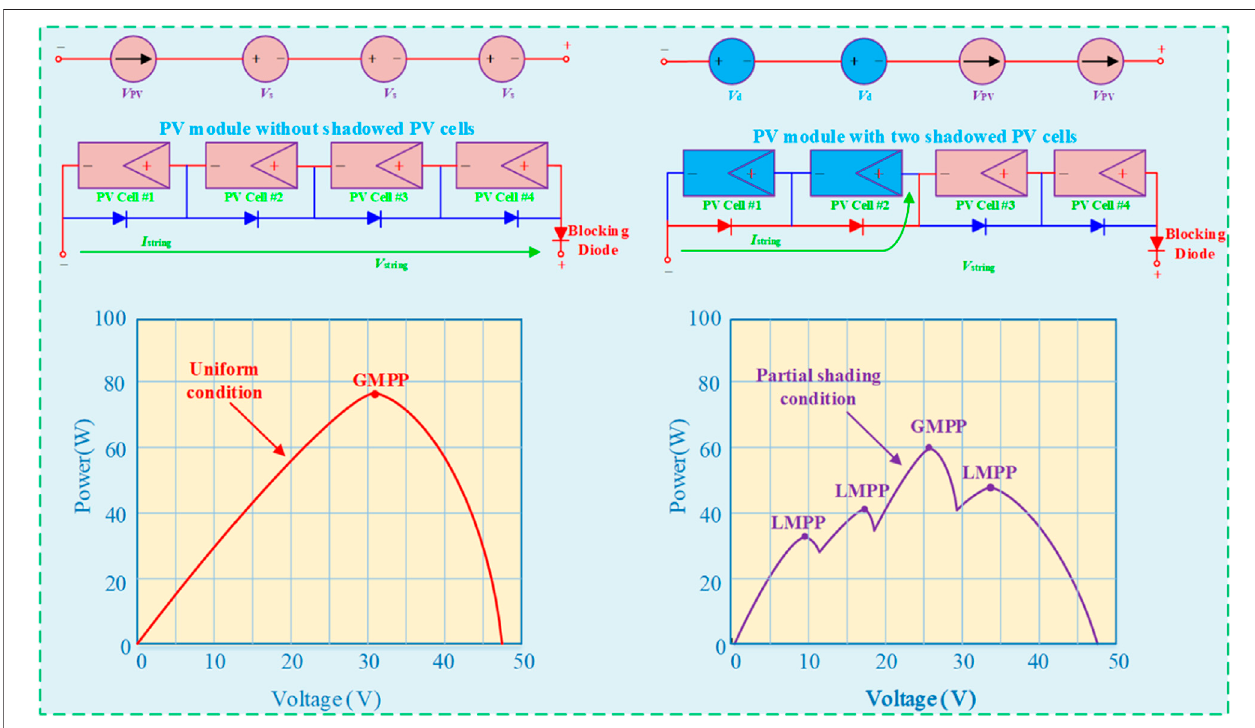
FIGURE 1 | P - V characteristic of PV systems under